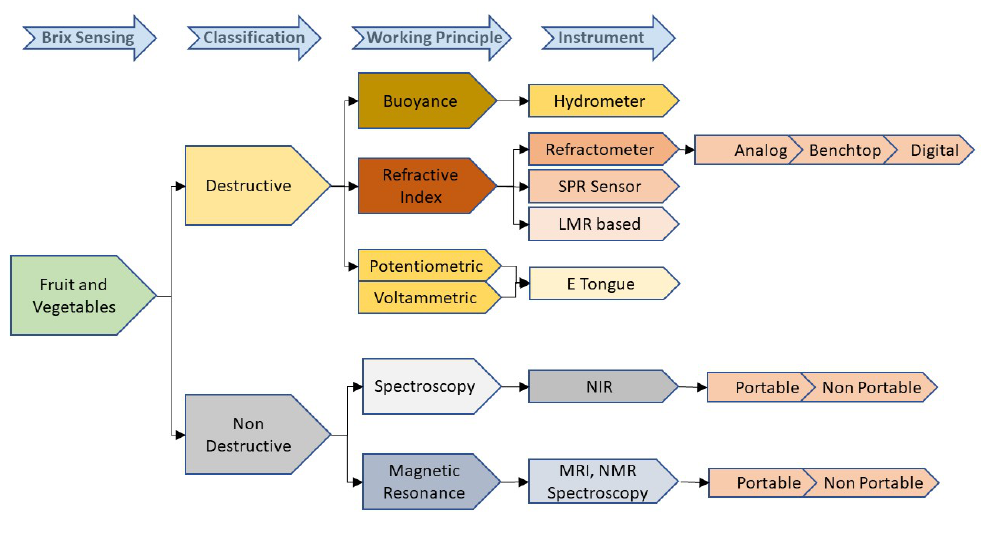
Figure 7. Brix measurement methods for fruits and vegetables.